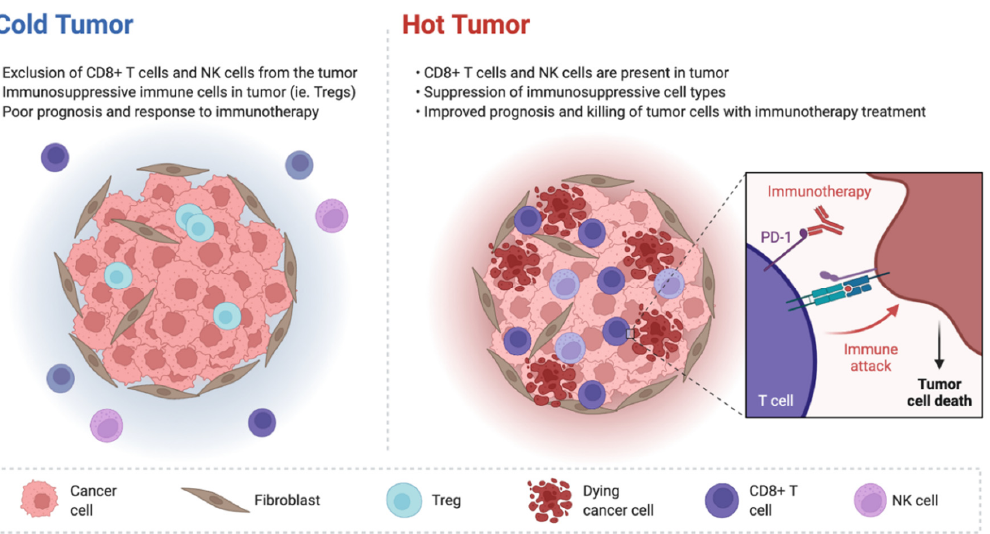
Figure 1. Schematic figure representing immunologically “cold” and “hot” tumors. Hot tumors are infiltrated by CD8+ T cells and NK cells, while immunologically cold tumors lack these cells. Conversely, immunologically “cold” tumors are characterized by a lack of tumor ‐ infiltrating lymphocytes and cytokines with cytotoxic activity. EC represents the solid tu ‐ mor with the greatest percentage of MSI ‐ H/dMMR cases, ranging from 25 to 30%, accord ‐ ing to recent studies [20]. Since MSI ‐ H/dMMR tumors carry from 10 to 100 times as many somatic mutations compared with MMR ‐ proficient (pMMR)/microsatellite stable (MSS)